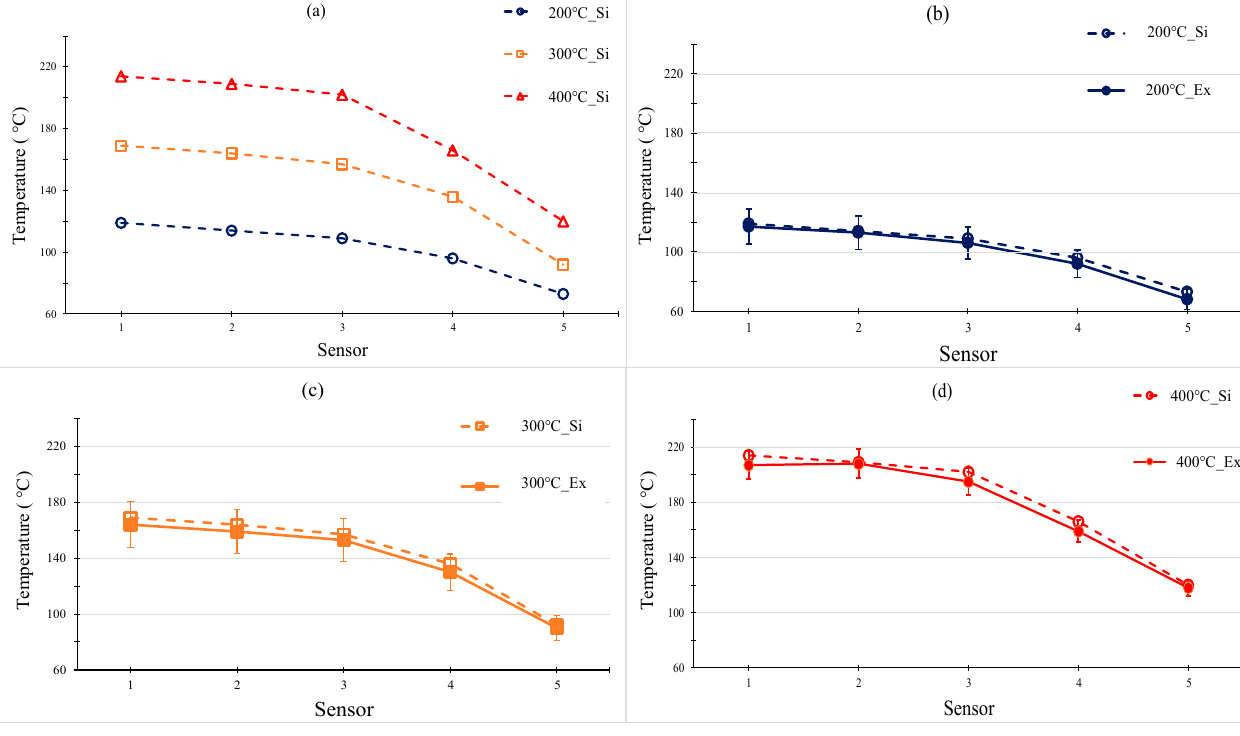
Figure 13. The comparison of temperatures along the center line by simulation ( a ) with different inlet temperatures with a